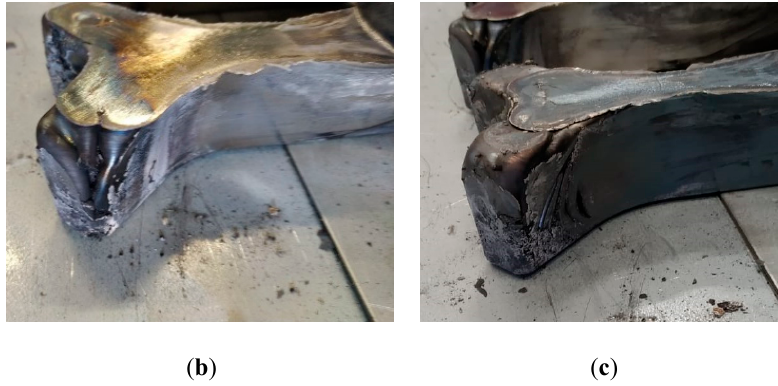
Figure 8. ( a ) Obtained components in Trials 1, 2 and 3, respectively, (from left to right). Detail of the last part filling (fingers) in ( b ) Trial 2 and ( c ) Trial 3.